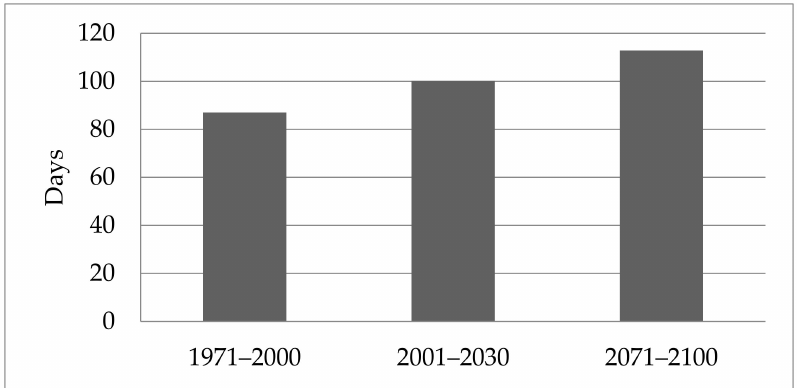
Figure 5. The duration of the growing season of spring barley over the baseline period (1971–2000) and in the projected climate scenarios (2001–2030 and 2071–2100).